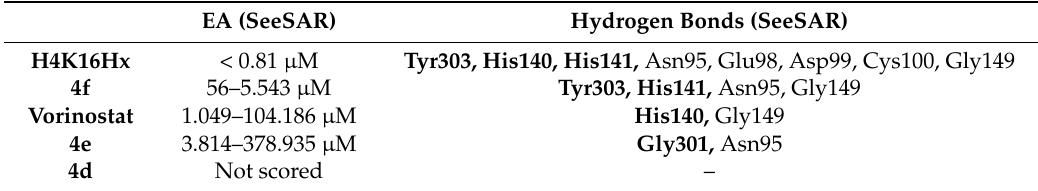
Table 6. SeeSAR docking results including estimated affinities (EA) and hydrogen bonds for HDAC1 structure 5ICN ordered by best estimated